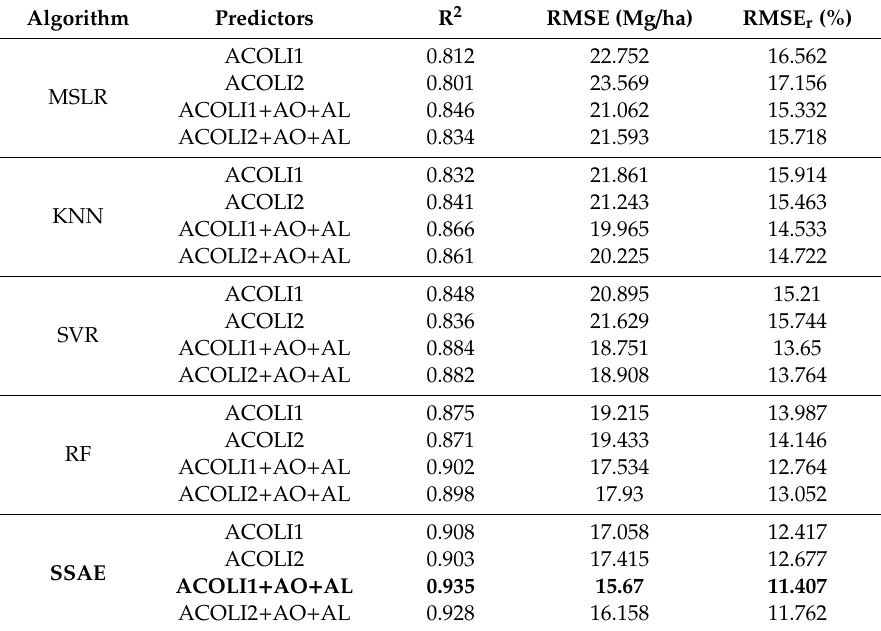
Table 6. Accuracy assessment for models in Experiment